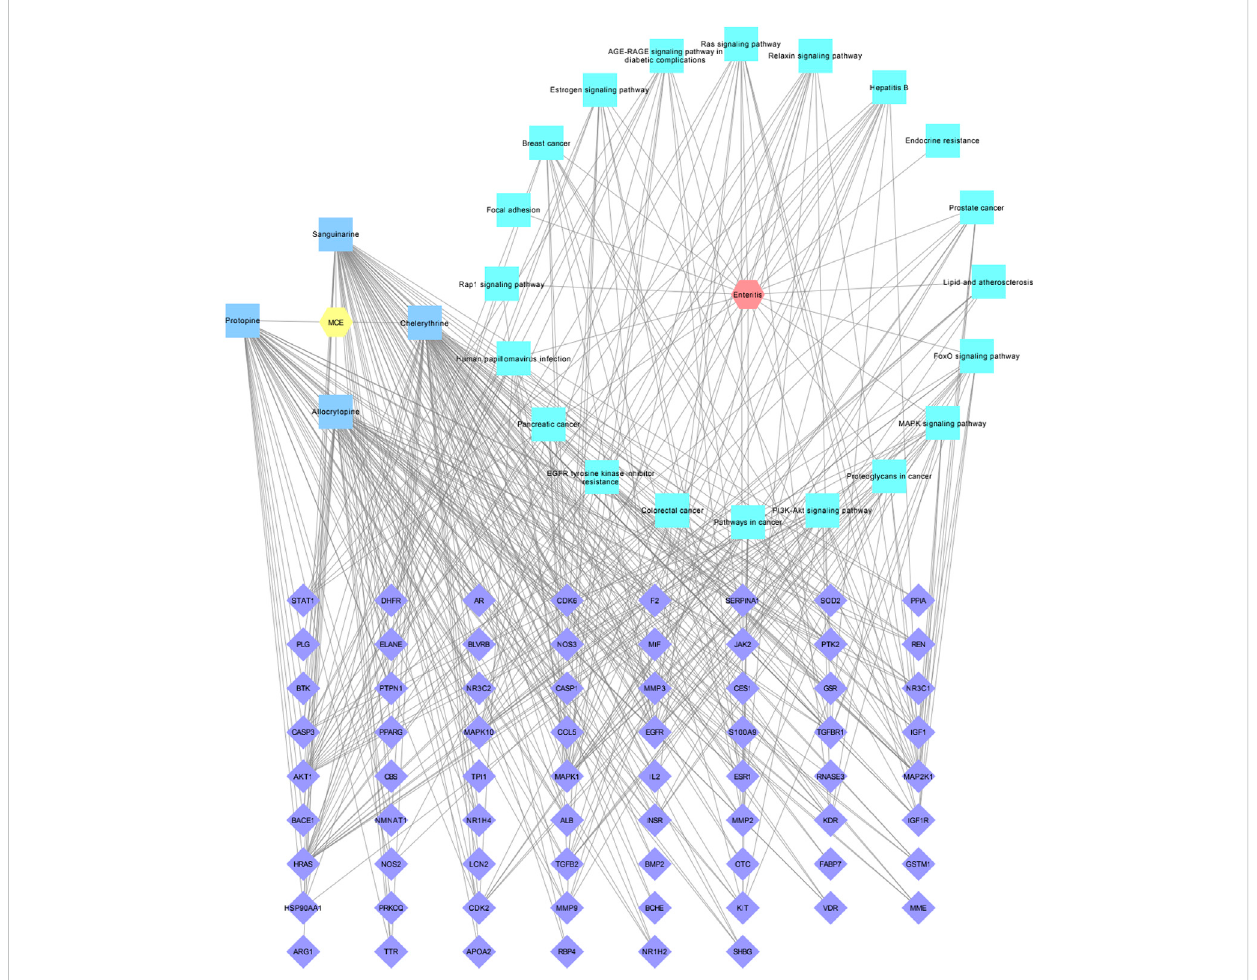
FIGURE 5 Drug – active compound – target – pathway – disease network diagram. The yellow hexagon represents MCE, the red hexagon represents enteritis, four blue squares represent MCE active compounds, 20 green squares represent pathways, and 70 purple diamonds represent intersection targets.